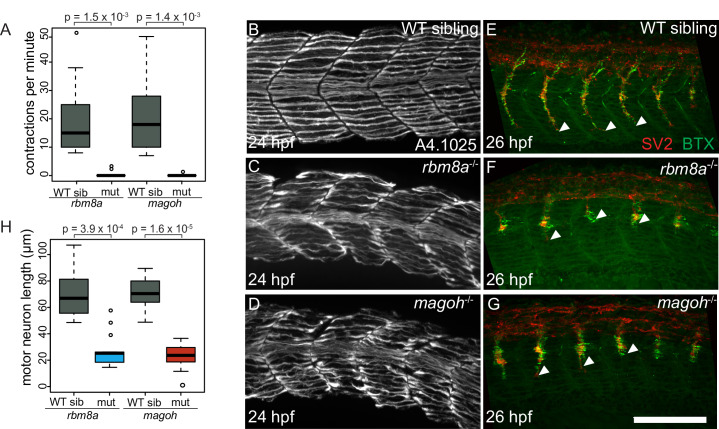
EJC mutant embryos are paralyzed, have disorganized muscles and stunted motor axons.A. Boxplots showing the number of spontaneous contractions per minute measured for the EJC mutant embryos and WT siblings at 24 hpf as indicated on the x-axis. Welch’s t-test p-values are indicated at the top. B-D. Immunofluorescence images showing Myh1 expression in somites 10–14 of WT sibling (B) rbm8a mutant (C) and magoh (D) mutant embryos. Antibody used was anti-A4.1025 (see methods) (N = 10 embryos/genotype). E-G. Merged confocal images of somites 12–16 in WT siblings (E) rbm8a (F) and magoh (G) mutant embryos showing immunofluorescence detection of motor neurons (anti-SV2; red) and acetylcholine receptors (α-Bungarotoxin; green). Neuro-muscular junctions in the merged image appear yellow. White arrowheads point to the end of the motor neuron. Scale bar in G is 100 nm. H. Boxplots showing the quantification of motor axon length in somites 12–15 of wild-type sibling, rbm8a mutant, and magoh mutant embryos (N = 4 embryos/genotype and 4 neurons/embryo). Welch’s t-test p-values are at the top.